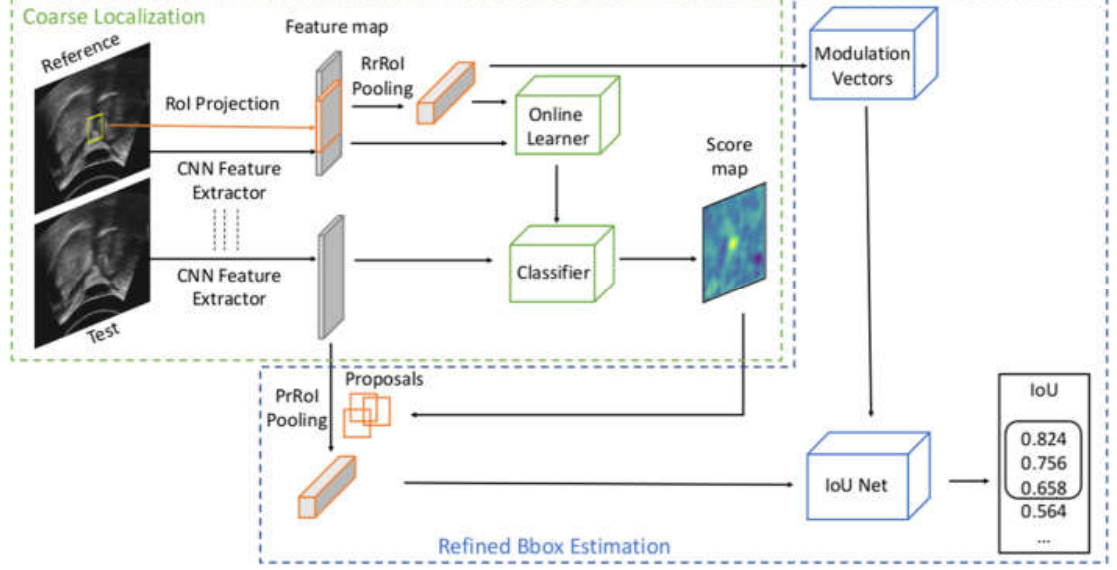
Figure 3. Workflow of multi-stage trackers. Precise region of interests (PrRoI) pooling layers [35] can convert features of different sizes into the same size while enabling the computation of the gradient of Intersection over Union (IoU) with respect to the bounding box coordinates. IoU Net outputs IoU scores for each proposal, and the top three ranked proposals are averaged to produce a robust prediction bounding box location.